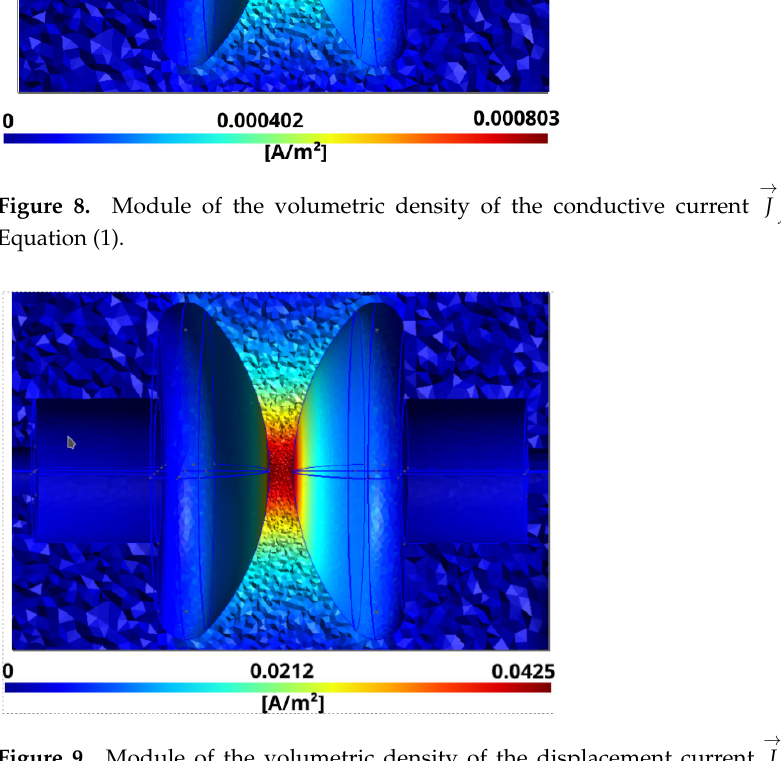
→ J d corresponding to